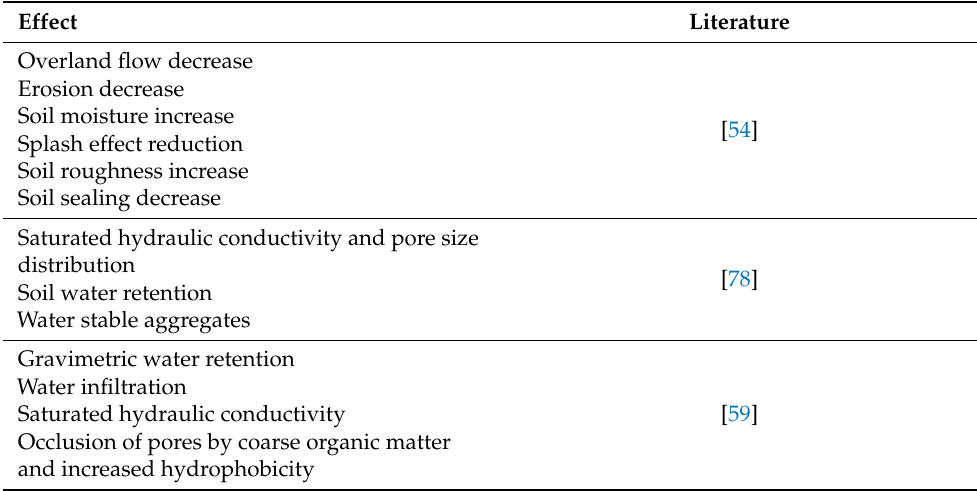
Table 5. Positive effect of use of organic matter on hydrology of degraded